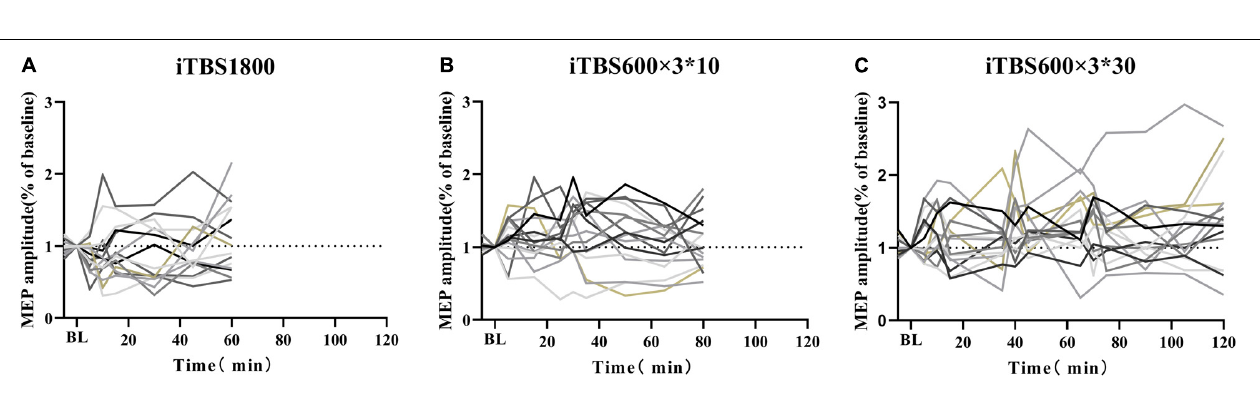
FIGURE 5 | Individual response to iTBS after 1800 pulses stimulation in three different intervals. (A) iTBS1800 (B) iTBS600 × 3 ∗ 10 (C) iTBS600 × 3 ∗ 30.